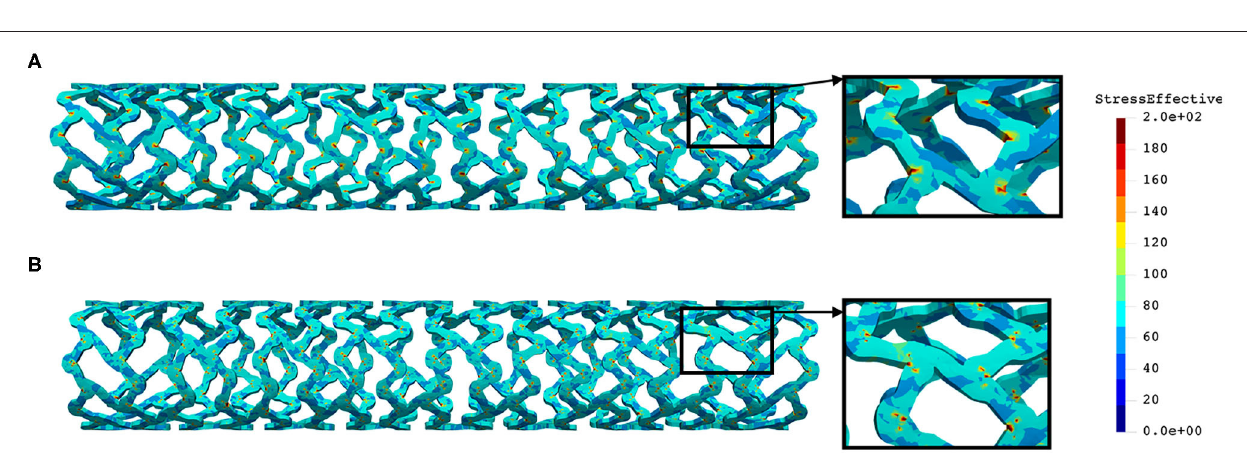
FIGURE 8 | Effective stress distribution on PLLA prot (A) and PLLA prot-slots (B) stents for inflation test.